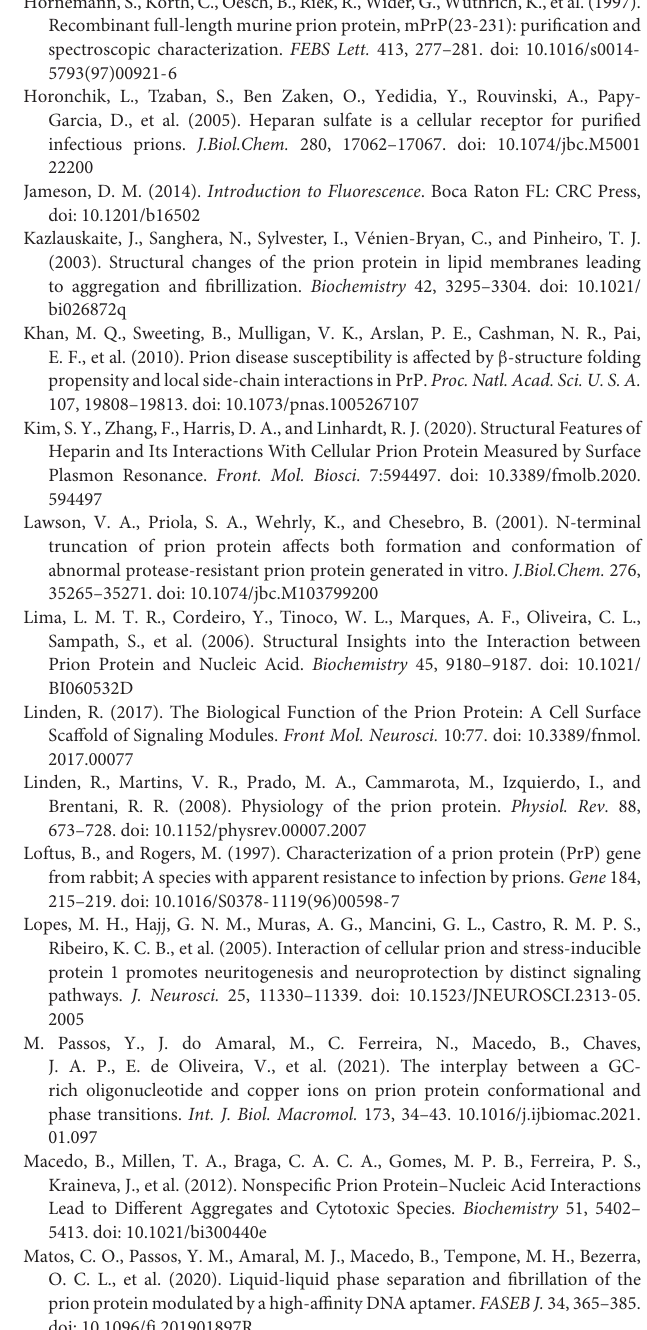
Supplementary Figure 2 | Interaction with PA leads to increased tryptophan fluorescence and spectral shift to lower wavelengths. (A–D) Spectra based on the intrinsic tryptophan fluorescence emissions of murine (A,C) and rabbit (B,D) PrP 23 − 231 (A,B) and PrP 90 − 231 (C,D) . Self-normalized spectra of murine (E,G) and rabbit (F,H) PrP 23 − 231 (E,F) and PrP 90 − 231 (G,H) . Solid lines represent PrP alone. Dashed lines represent PrP in the presence of PA. All proteins were at 2 mM and PA at 30 mM. The experiments were performed in 50 mM Tris buffer containing 100 mM NaCl at pH 7.4 or in 20 mM sodium acetate buffer containing